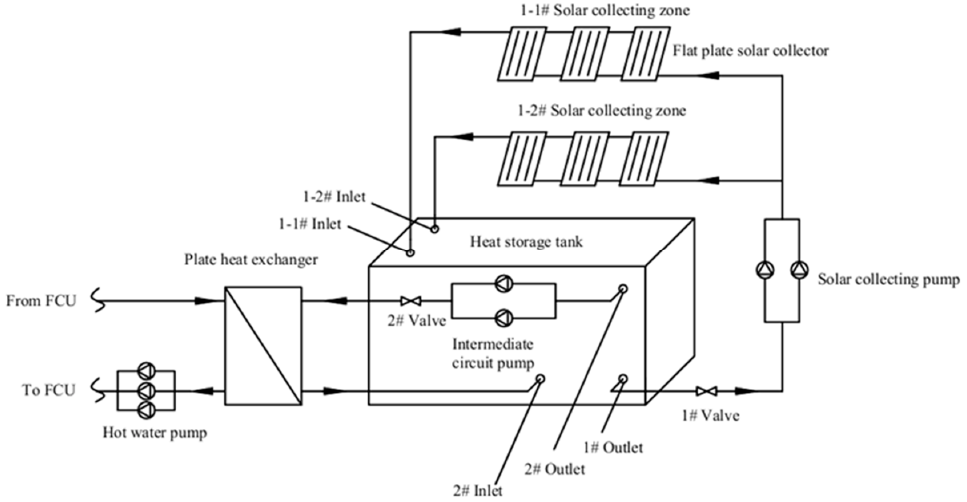
Figure 1. Schematic diagram of the solar heating system.